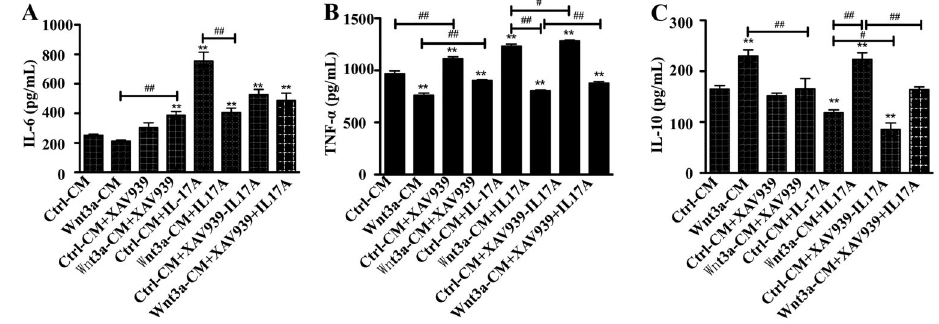
Figure 4. Production of cytokines in RAW264.7 cells in response to Wnt3A and/or interleukin (IL)-17 stimulation. A – C , Concentration of IL-6, tumor necrosis factor (TNF)- a , and IL-10 in culture media of cells treated with Wnt3A-CM and/or XAV939 without rhIL-17A or with rhIL-17A. **P o 0.01 compared to Ctrl-CM group, # P o 0.05, ## P o 0.01 compared to the indicated groups